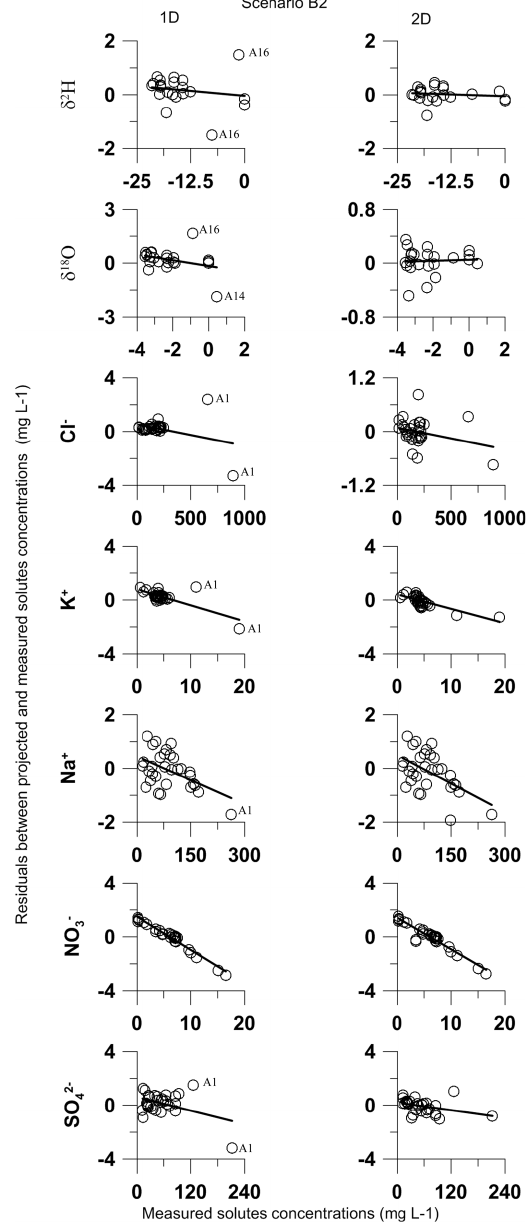
Fig. 6b. Plot of residuals versus original concentrations of solutes and stable isotopes for wet and dry seasons from the 1-D mixing space and 2-D mixing spaces for Scenario B2 (outliers are identified in the